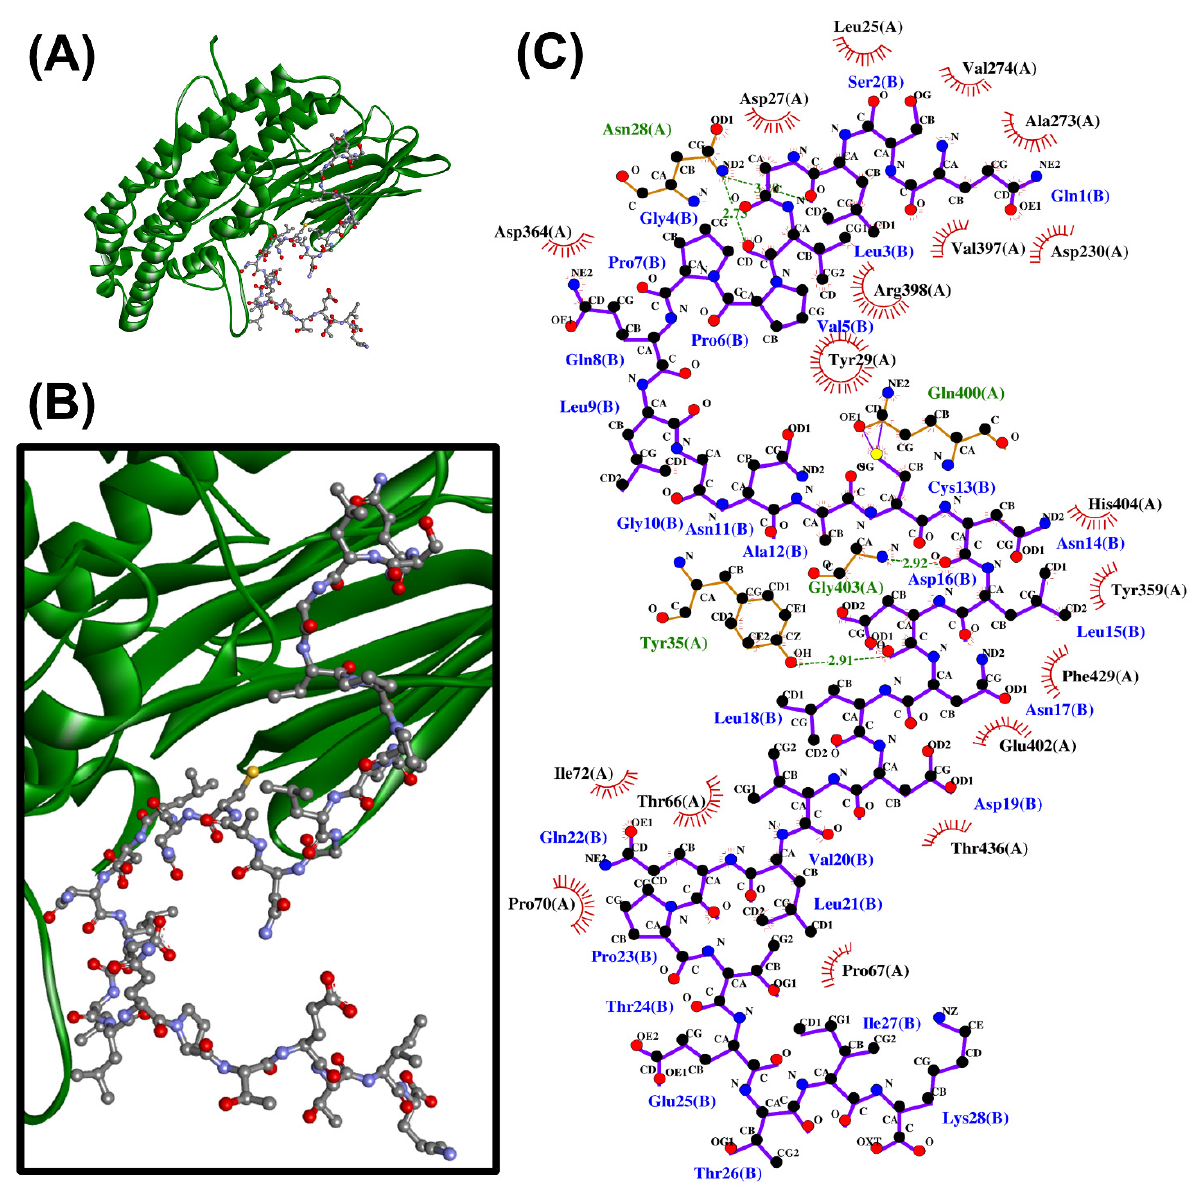
Figure 2. The QSLGVPPQLGNACNLDNLDVLQPTETIK-PirB vp docked model presented in 3D ( A , B ) and 2D ( C ) diagrams. In ( A , B ), PirB vp is shown in the cartoon in green; QSLGVPPQLGNACNLDNLDVLQPTETIK is presented in a ball-and-stick style. In the 2D diagram ( C ), the hydrophobic bonds, hydrogen bonds, and external bonds are displayed in red spoked arcs, green dashed lines, and purple lines, respectively.